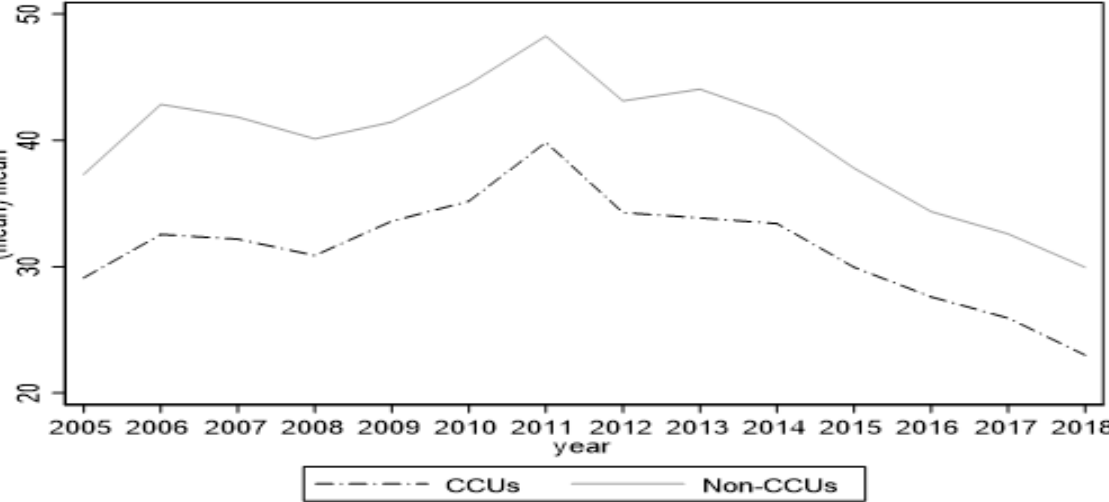
Figure 3. Air pollution trend comparison 2005–2018. Note: the figure illustrates the time trends of PM2.5 (mean) of the CCU counties (i.e., counties that adopted the CCU policy since 2005) and that of non-CCU counties (i.e., counties that did not adopt the CCU policy during the sample period).